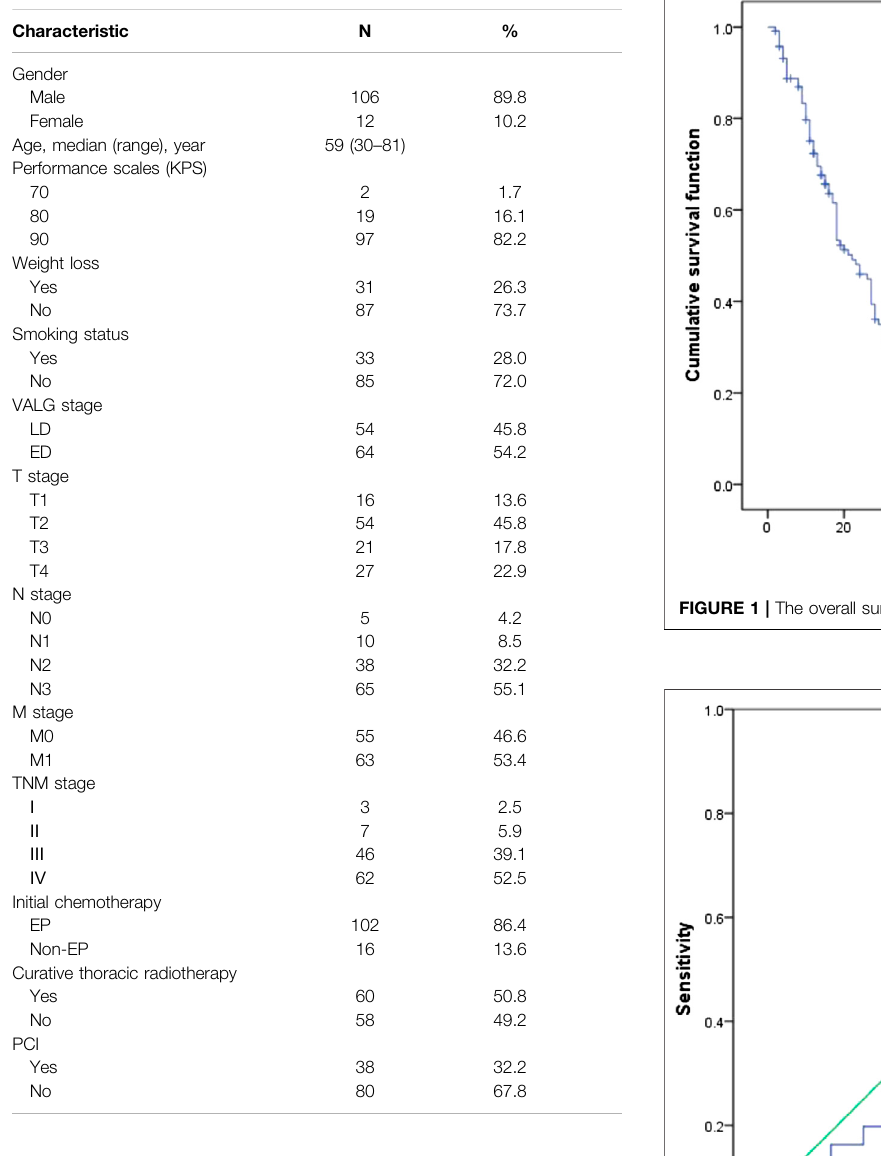
Table 1 . The median age of the patients was 59 years (ranges